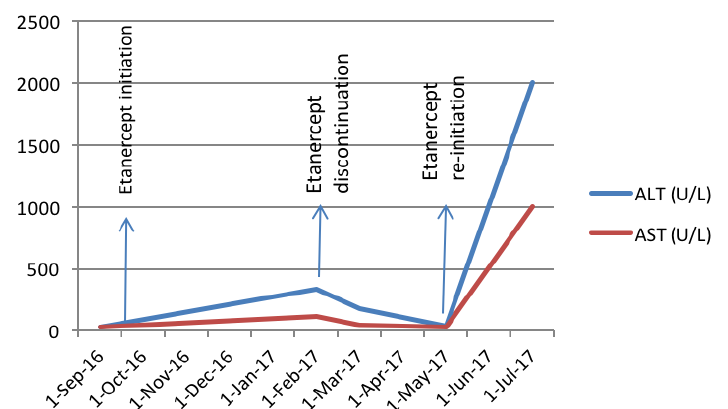
Fig. 1. Patient's serum transaminases level during Etanercept treatment